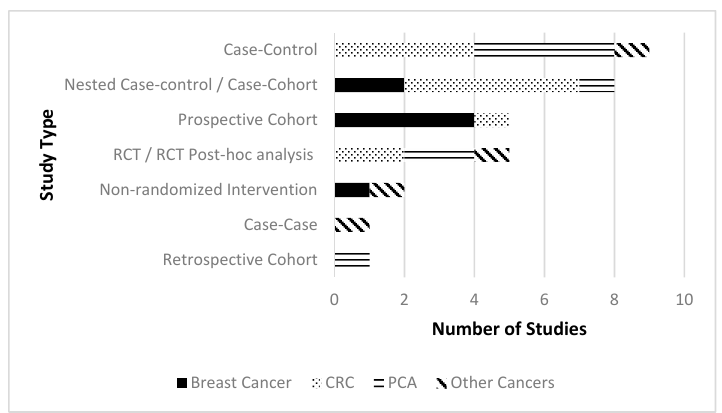
Figure 3. Number of studies by study design type split by cancer type.